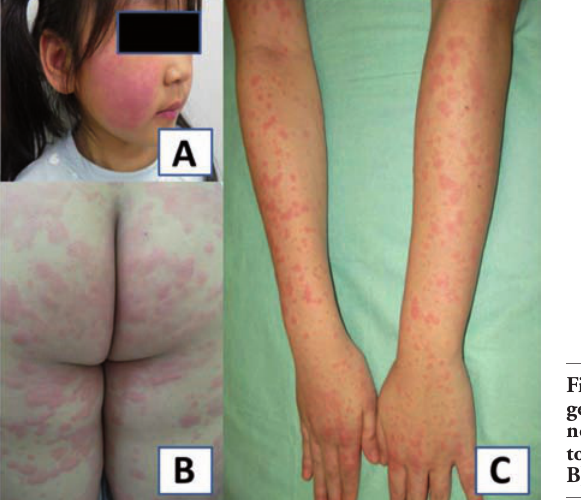
Figure 1. Various forms of geographically distributed non-exudative erythema- tous eruptions. A) Case 5, B) Case 1 and C) Case